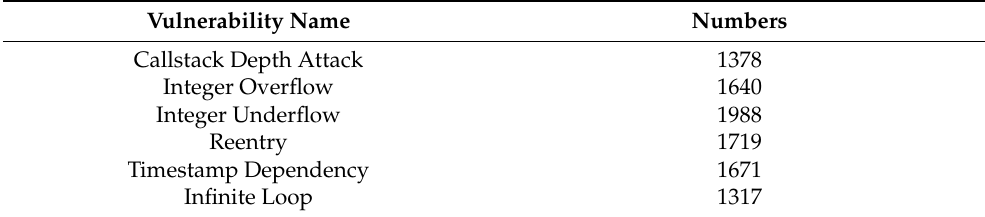
Table 1. Number of smart contract vulnerabilities.